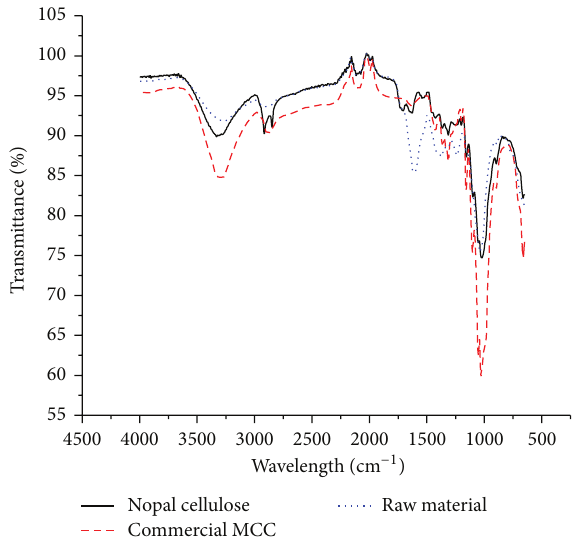
Figure 4: X-ray diffraction patterns of nopal and microcrystalline